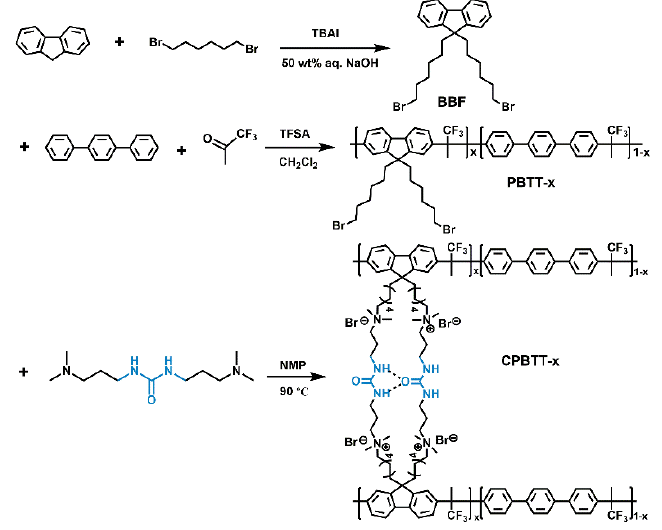
Figure 1. Synthetic route to the CPBTT − x AEMs.